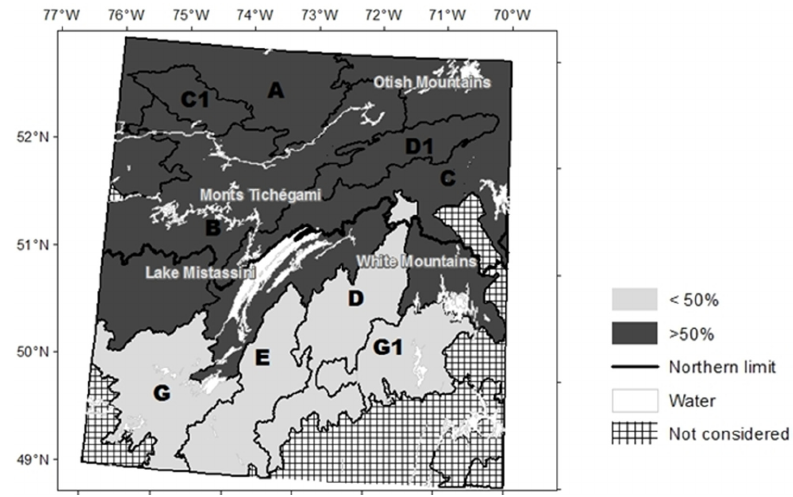
Figure 2. Average proportion by fire zones of the abundance of open stands in 2006.